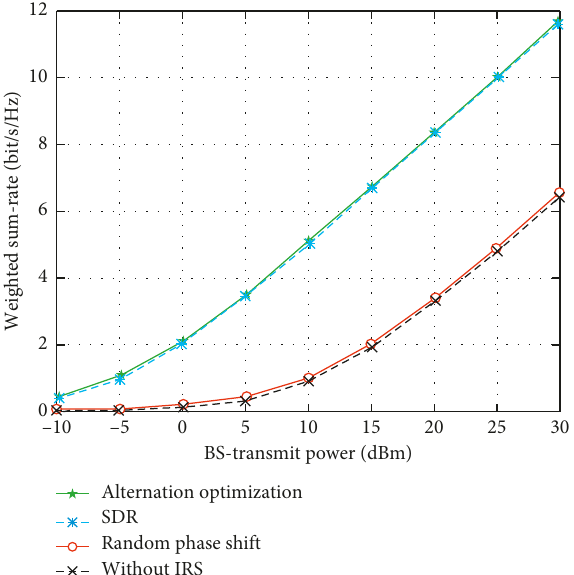
Figure 7: Change curve of the achievable rate with the number of users.